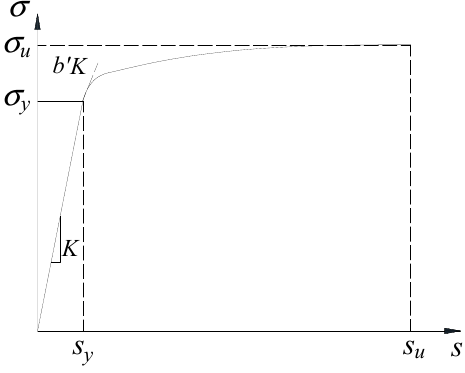
Figure 3. Envelope curve for rebar stress versus loaded-end slip relationship.